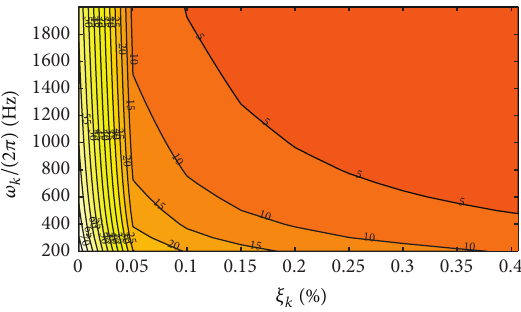
Figure 17: Perf |𝑇 𝑧𝑤 | max as function of 𝜉 𝑘 and 𝜔 𝑘 for 𝜓 2 𝑘 𝛾 Table 4).